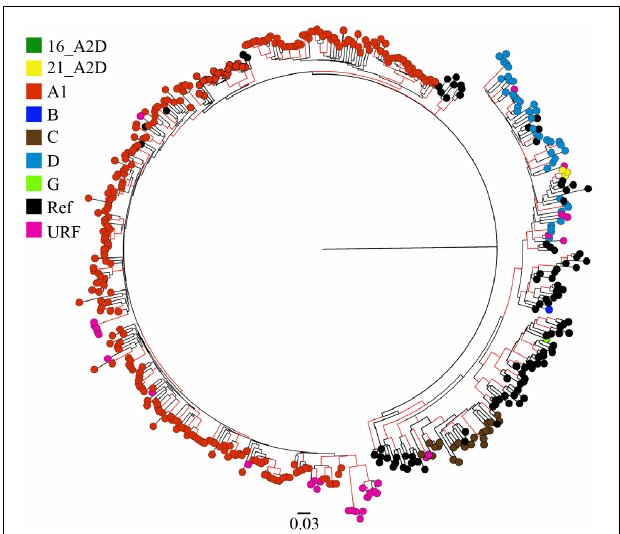
FIGURE 2 | HIV-1 genotypes among 372 MSM sequences from Kenya. Maximum-likelihood phylogenetic tree of 372 HIV-1 pol sequences from MSM living with HIV-1 in Kenya (and 194 HIV-1 Group M subtype reference sequences from the Los Alamos HIV database). Branch tips colors correspond to the respective HIV-1 subtype, sub-subtype, or recombinant form as shown in the legend. Branches with aLRT-SH support of more than ≥ 0.9 are colored red. The tree is drawn to scale, with branch lengths measured in the number of substitutions per